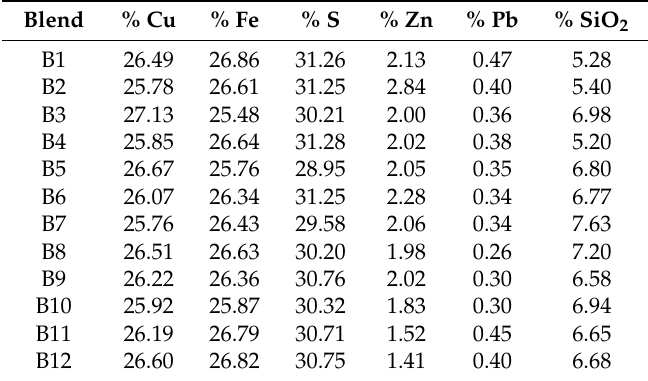
Table 11. Zinc and lead content in matte and slag. Industrial Data / wt.% Industrial Data / wt.% Blend